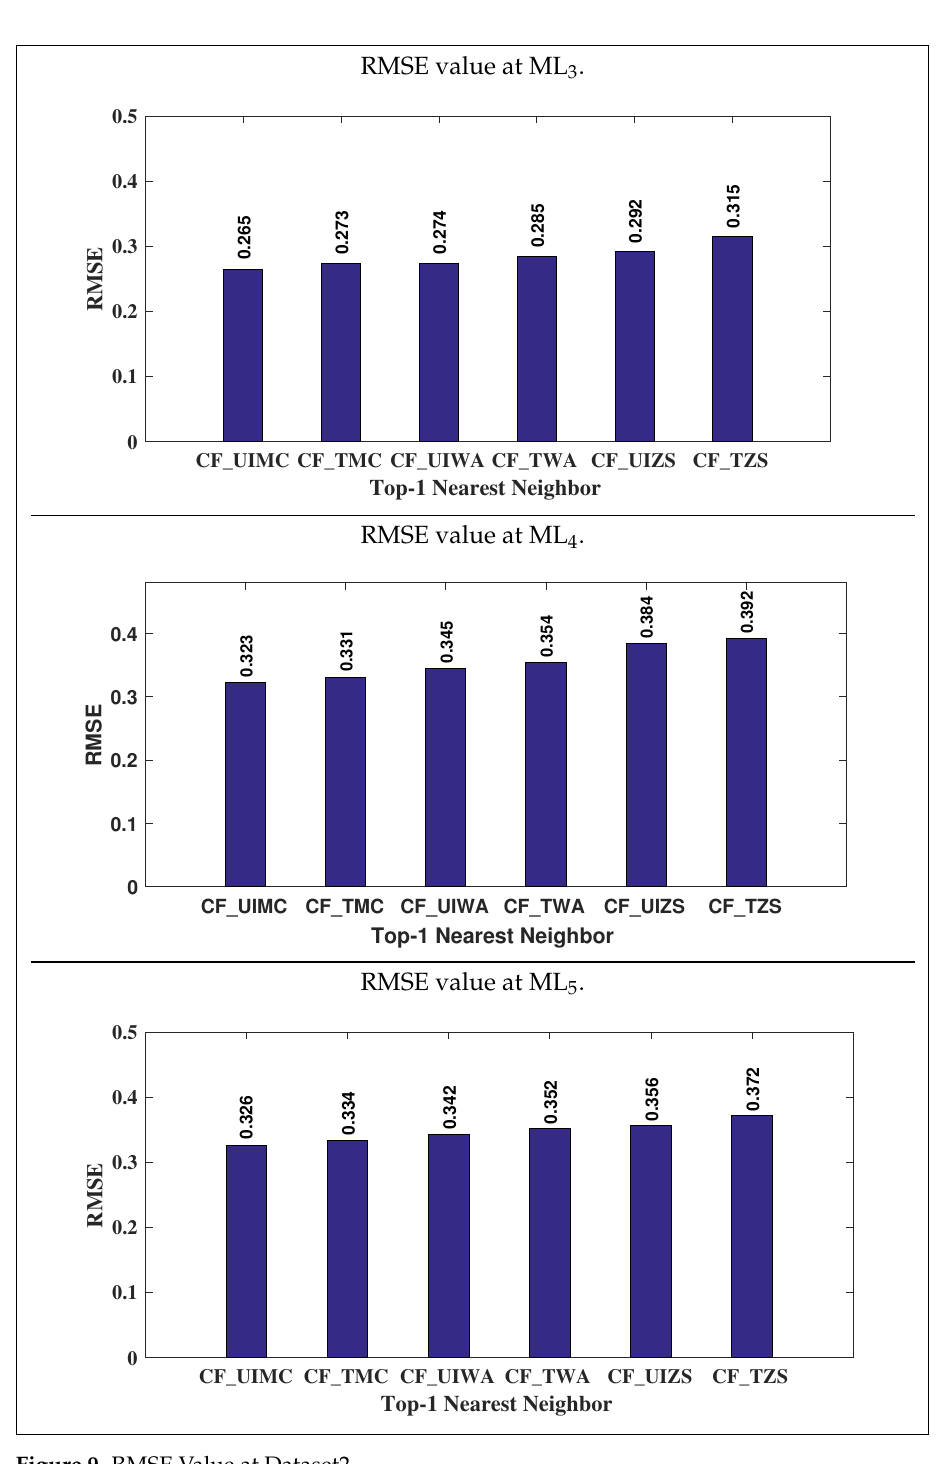
Figure 9. RMSE Value at